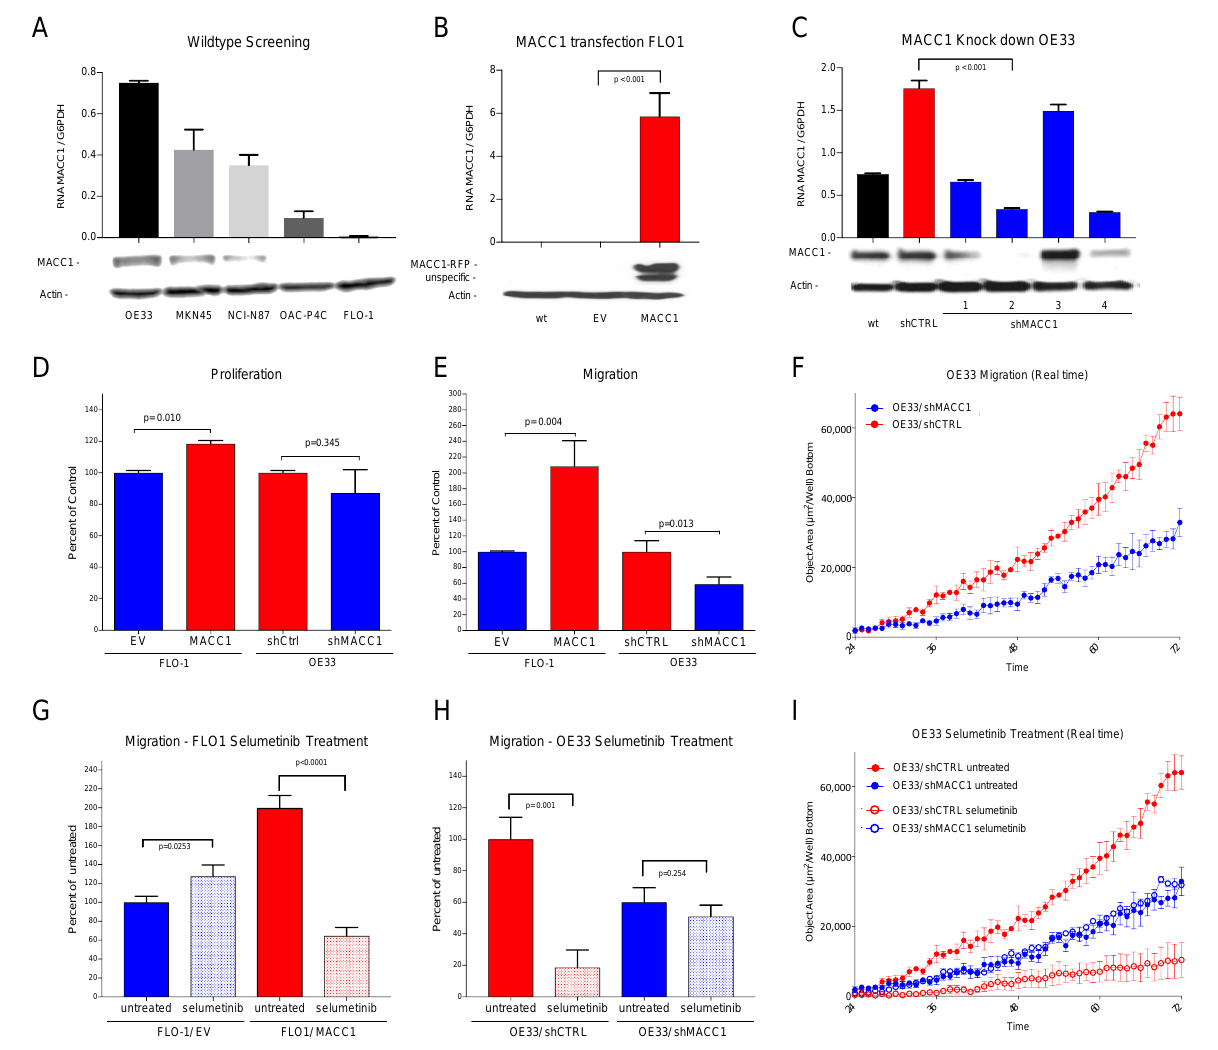
Figure 3. ( A ) Western blot and RNA expression of cell lines OE33, MKN45, NCI-N87, OAC-P4C and FLO-1: high MACC1 expression in OE33 cells, negligible MACC1 expression in FLO-1 cells. ( B ) Western blot and RNA expression of MACC1-transfected cell line FLO-1. wt = wild type, EV = empty vector and MACC1; Significant overexpression of MACC1 in FLO-1/MACC1 compared to FLO-1/EV ( p < 0.001). ( C ) Western blot and RNA expression of different MACC1-downregulated OE33 subclones. wt = wild type, shCTRL = scrambled sh control, shMACC1 1–4 = 4 different MACC1 small hairpin vectors. ( D ) The FLO-1/MACC1 clone shows higher proliferation over 24 h compared to FLO-1/EV ( p = 0.010). OE33/shMACC1 showed no statistically significant difference ( p = 0.345) in comparison to OE33/shCTRL. ( E ) In the migration assay, over 72 h FLO-1/MACC1 cells migrate significantly more than FLO-1/EV cells ( p = 0.004), and OE33/shMACC1 cells significantly less than OE33/shCTRL cells ( p = 0.013). ( F ) Effects of MACC1 inhibition on migration in a real time plot over 72 h for OE33/shMACC1-negative (blue) and MACC1-positive OE33/shCTRL (red) cells. ( G ) Treatment with selumetinib (light colors) decreases migration of FLO-1/MACC1 cells (red) compared to untreated cells (dark colors) significantly ( p < 0.001). ( H ) Treatment with selumetinib (light colors) decreases migration of MACC1-positive OE33/shCTRL cells significantly compared to migration in untreated cells ( p = 0.001) (red). ( I ) Effects on migration by inhibition with selumetinib in a real time plot over 72 h: MACC1 knockdown OE33/shMACC1 cells in blue and MACC1-positive OE33/shCTRL in red. Selumetinib-treated cells are shown in light and untreated in dark colors. Significant effects on selumetinib treatment are only shown in the MACC1-expressing OE33/shCTRL